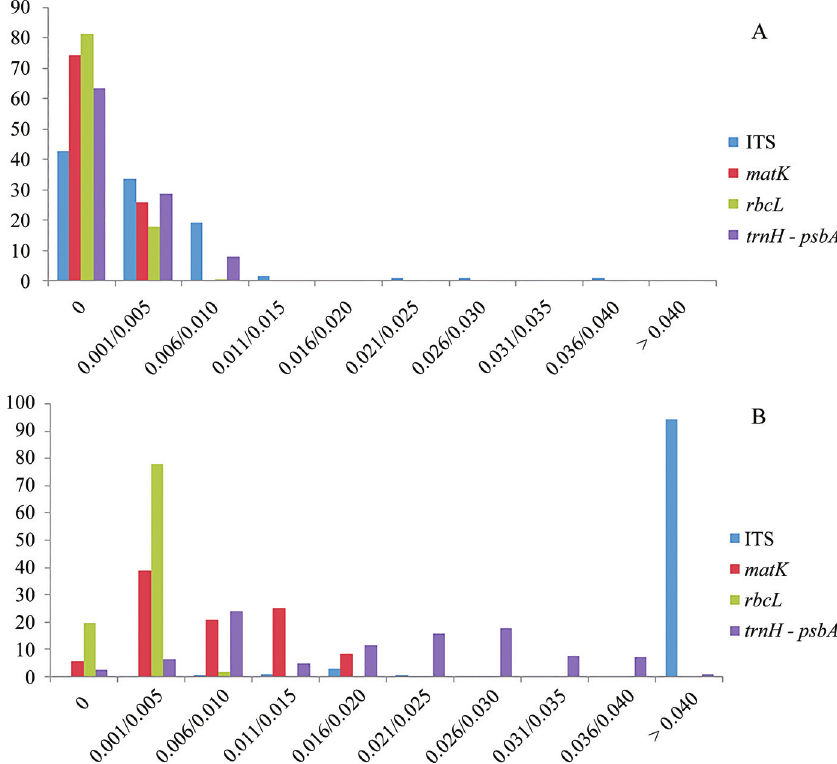
Figure 2 - Relative distribution of intraspecific (A) and interspecific (B) Kimura 2-parameter distances for ITS, matK , rbcL and trnH - psbA . Y-axes = rel- ative distribution